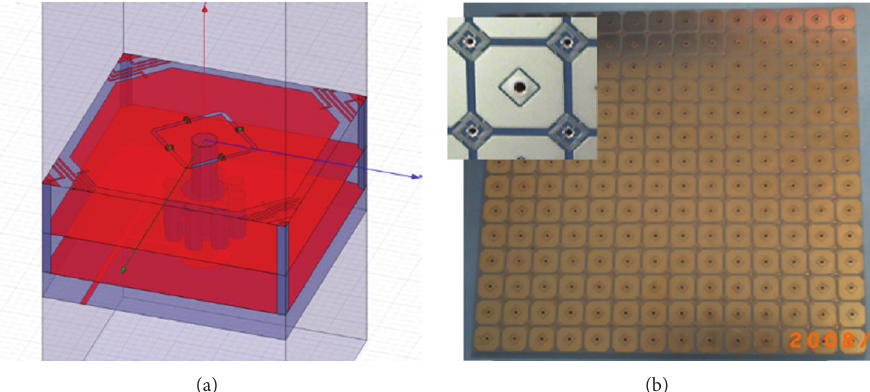
Figure 8: Basic geometry of the unit cell (a) and the array structure (b) of an adjustable high impedance surface [17].